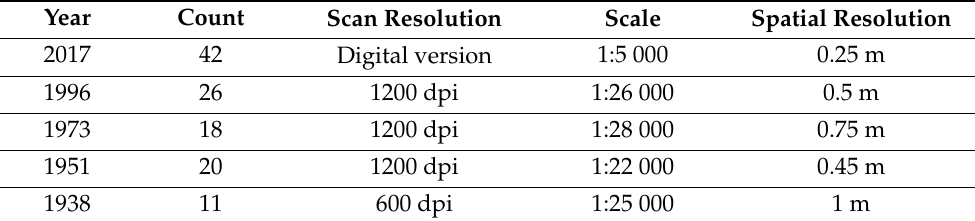
Table 1. Archival aerial photograph